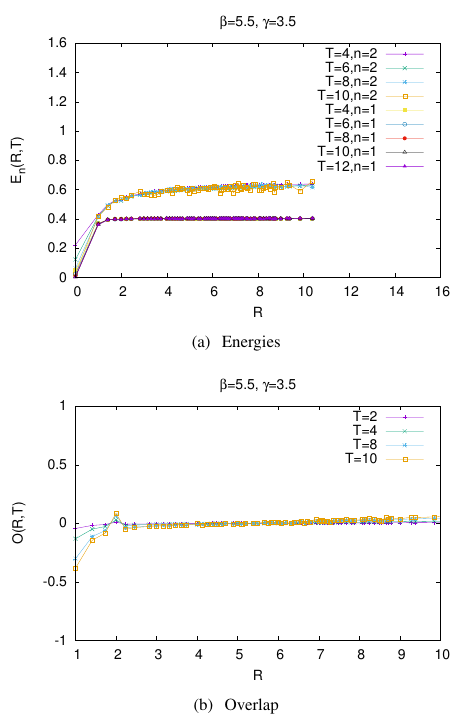
Figure 9. (a) Energies E 1 , 2 ( R , T ) of states Ψ 1 , Ψ 2 after evolution for a period of ( T − 1) / 2 units of Euclidean time, at lattice cou- plings β = 5 . 5 ,γ = 3 . 5. (b) The overlap O ( R , T ) between states Ψ Ψ 1 ( R ) and 2 ( R ) which are evolved (and then normalized) for T / 2 units of Euclidean